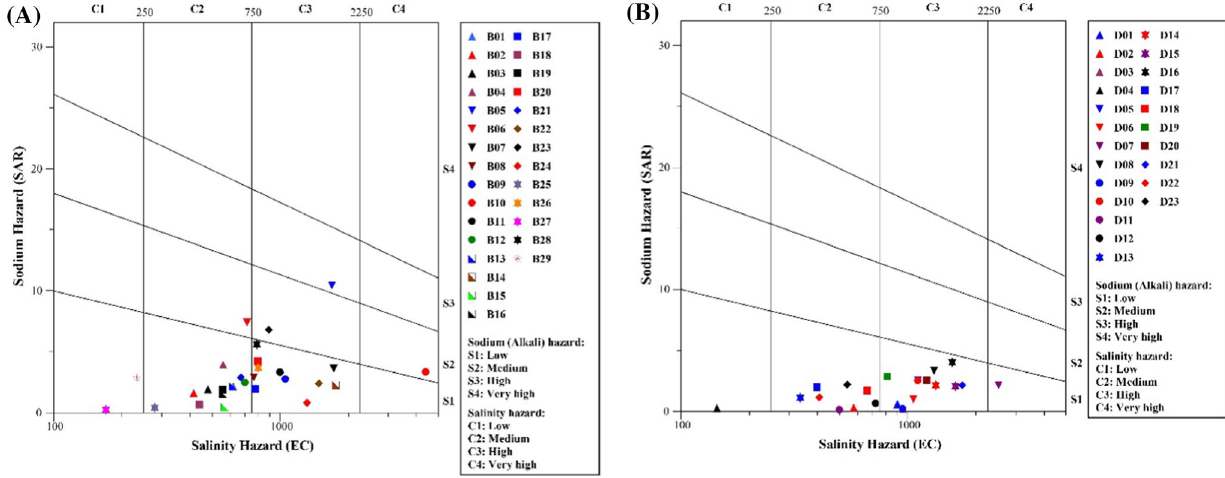
Fig. 9 Classification of irrigation water quality compared to the hazards of the salinity and sodium for (a) confined and (b) unconfined